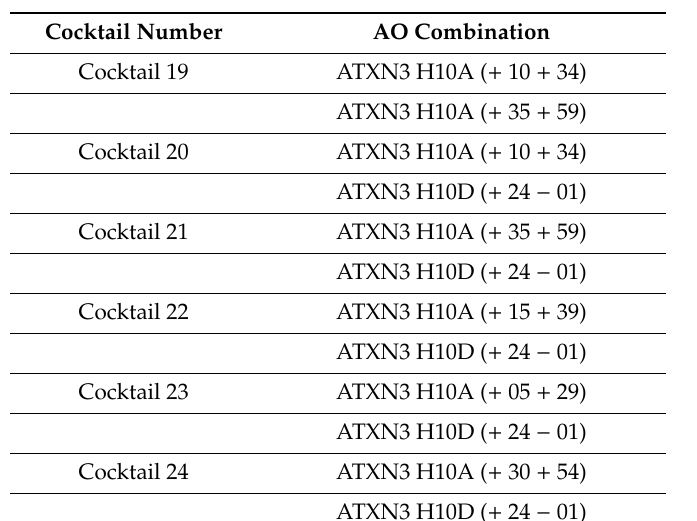
Table 2. AO cocktails containing two di ff erent, non-overlapping exon 10 sequences. Each cocktail comprises of a 1:1 molar ration of each